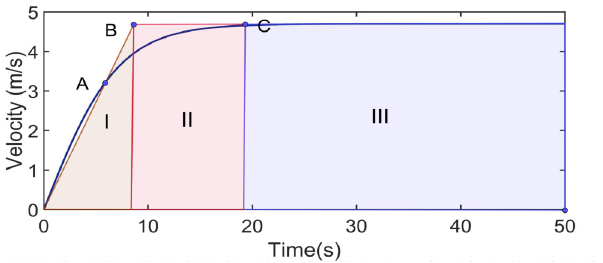
Figure 3. Velocity versus time curve, where the described intervals are drawn. (I) Constant acceleration interval, (II) stabilization interval and (III) constant velocity interval. (A) Point where 68% of velocity is reached, corresponding to time t 68 , expression (7); (B) cut-off point between the (I) and (II) intervals, corresponding to time t accel , expression (9); (C) cut-off points between intervals (II) and (III), corresponding to time t 99 , expression (7). See